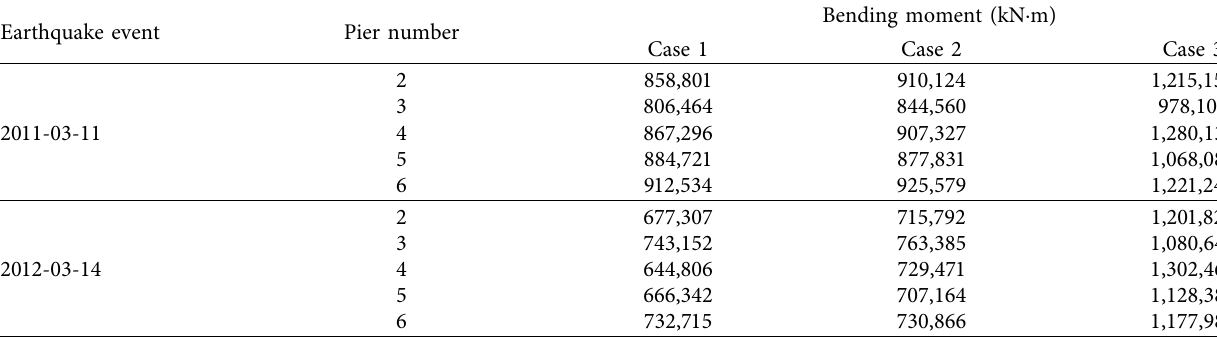
Figure 13: Shear force time history of No. 3 pier in the three earthquakes. (a) 2011-03-11. (b) 2012-03-14. (c) 2019-06-18. Table 6: Maximum bending moment of